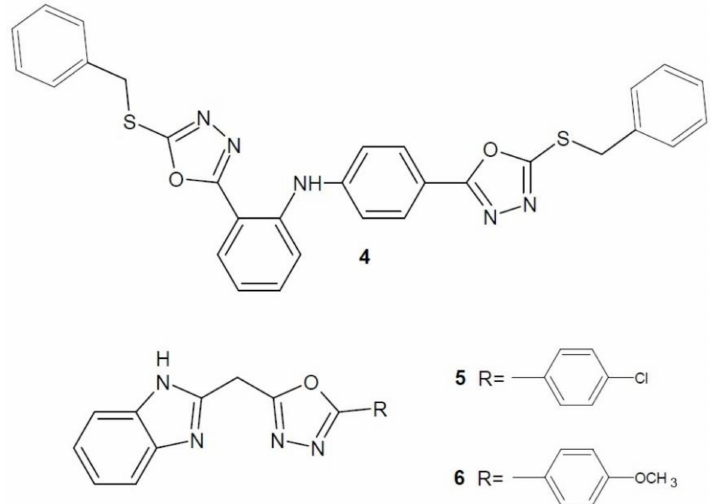
Figure 3. 1,3,4-Oxadiazole derivatives with activity of epidermal growth factor receptor